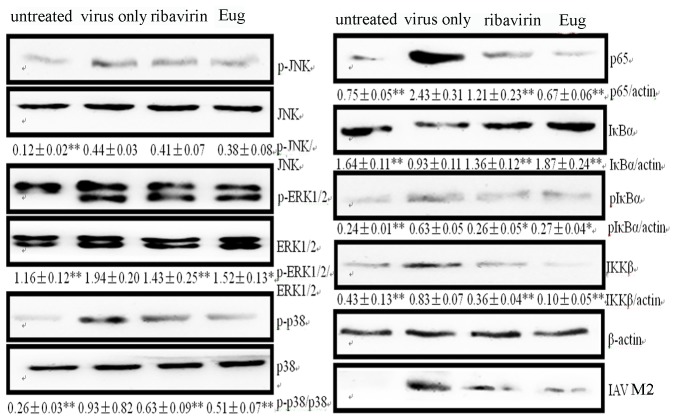
Effects of eugenol on the IAV-induced activation of ERK1/2, JNK1, p38MAPK and IKK/NF-κB signal pathways determined by Western blot.In the untreated group, A549 cells were not infected with IAV; in the negative control group (virus only), the cells were infected with IAV but not treated any drugs; in the ribavirin and Eug groups, the cells were infected, and treated with ribavirin (25 µg/mL) and eugenol (5 µg/mL), respectively. The infection time was 24 h, MOI = 0.001. The IAV strain was A/ShanTou/169/06(H1N1). The total gray value of each band was determined using Gel-Pro analyzer 6.0. The data were showed as the ratios of the target genes to β-actin. Data shown were the mean ± SD of three independent experiments. *P<0.05 and **P<0.01 vs the negative control group (virus only).